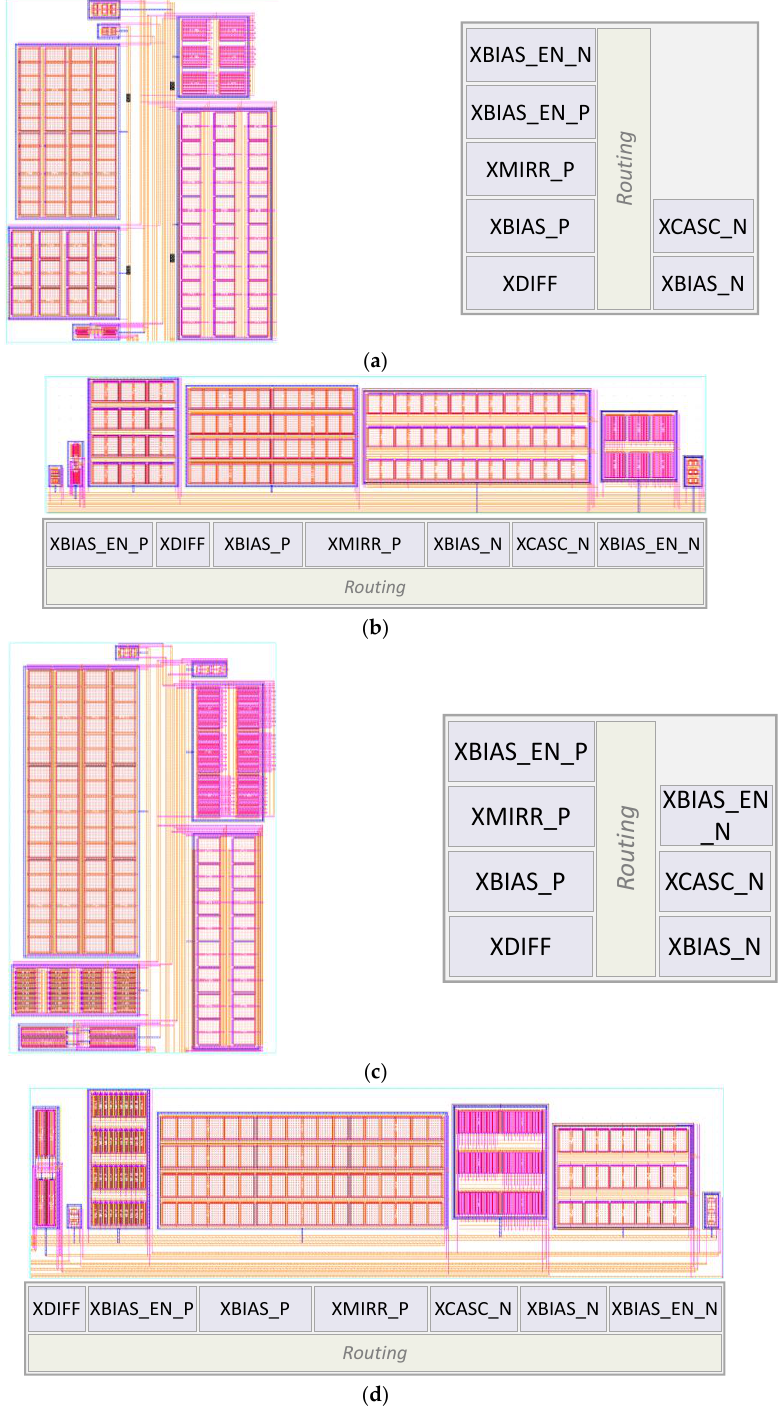
Figure A2. Generated layout examples (in a 22 nm technology) of amplifier variants by utilizing the presented method of template-based automatic generator code creation. Results for sizing “LP” are shown in ( a , b ) and results for sizing “Speed” are shown in ( c , d ). Besides sizing, the generated layouts are varied regarding placement patterns (street with one row and once with simpler routing vs. two rows and different arrangements each) and rotation patterns.